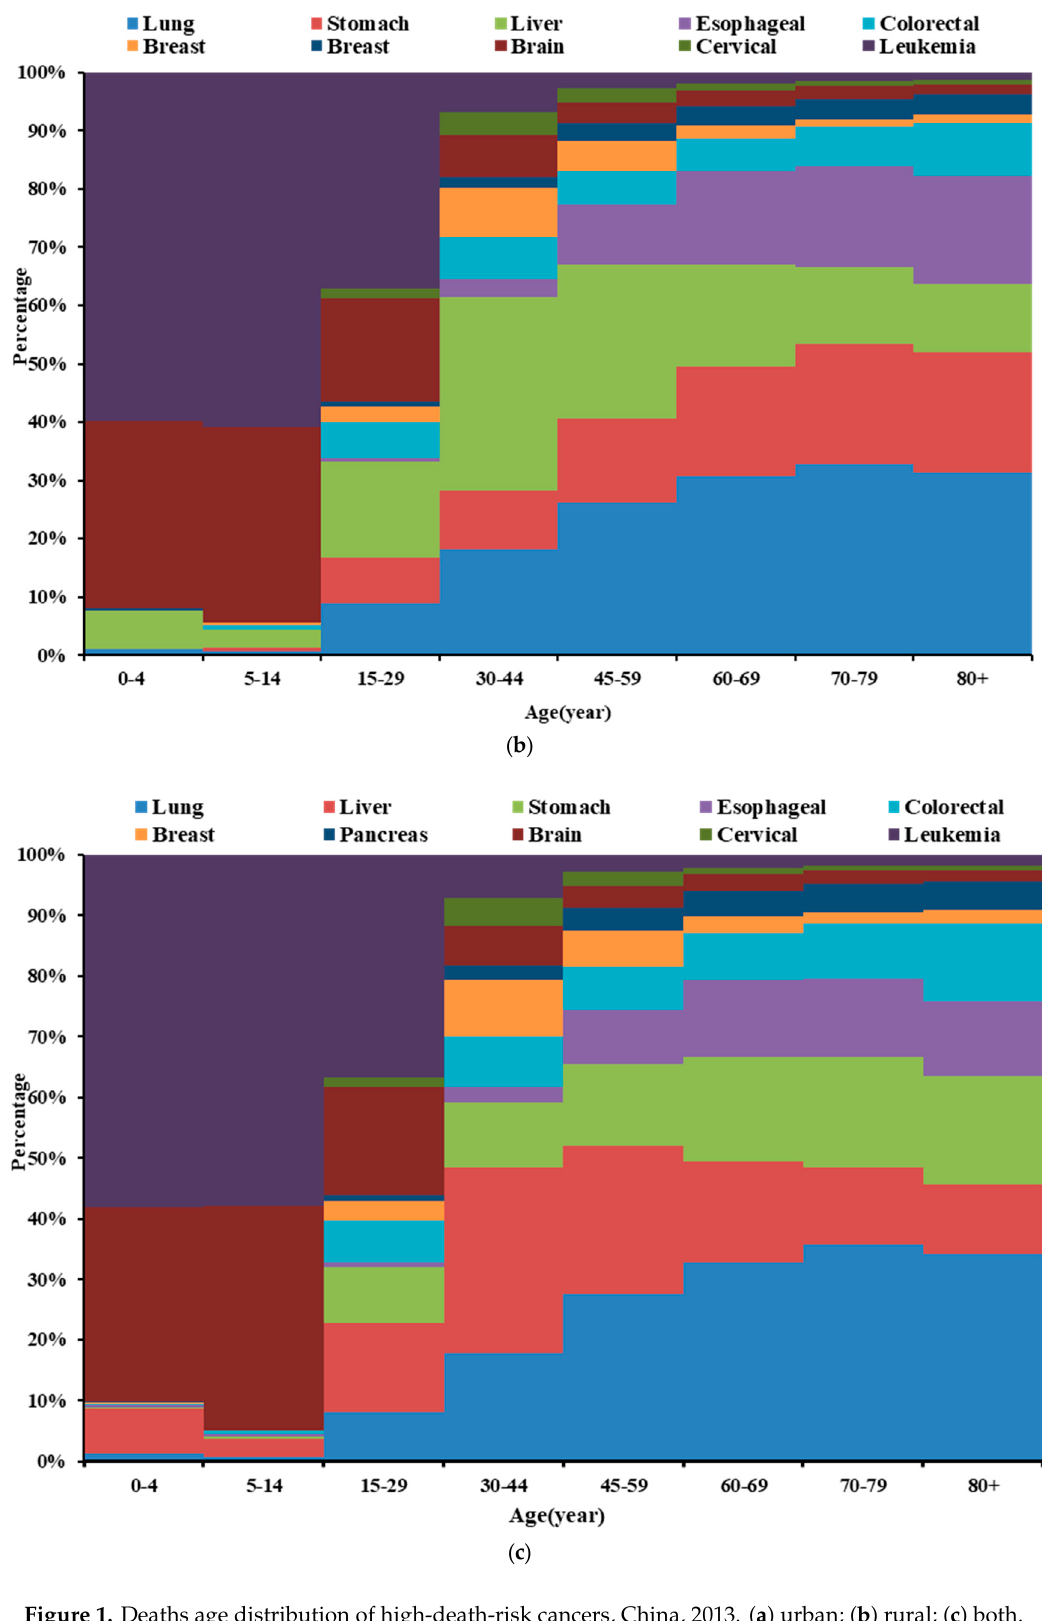
Figure 1. Deaths age distribution of high-death-risk cancers, China, 2013. ( a ) urban; ( b ) rural; ( c ) both.